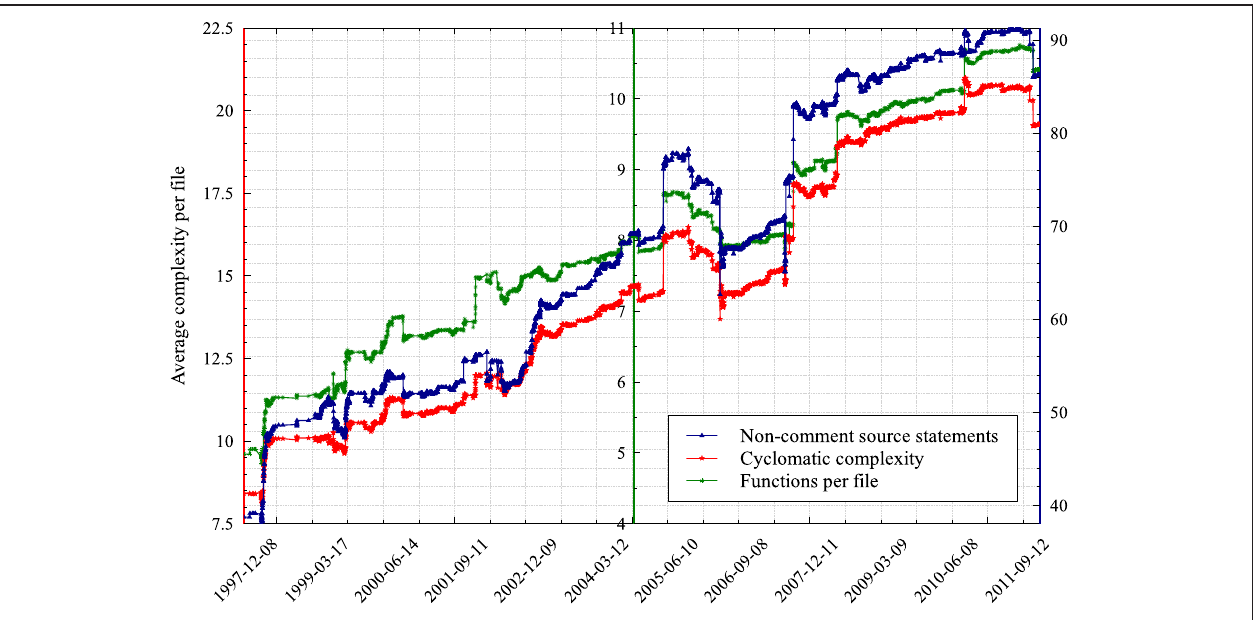
FIGURE 8 | The evolution in time of the average complexity per file of the NEST simulator code base. In this experiment we applied three different industry-standard techniques for estimating the complexity of a code base to every single revision recorded in the NEST version control repository. Cyclomatic complexity is a metric that measures the number of linearly